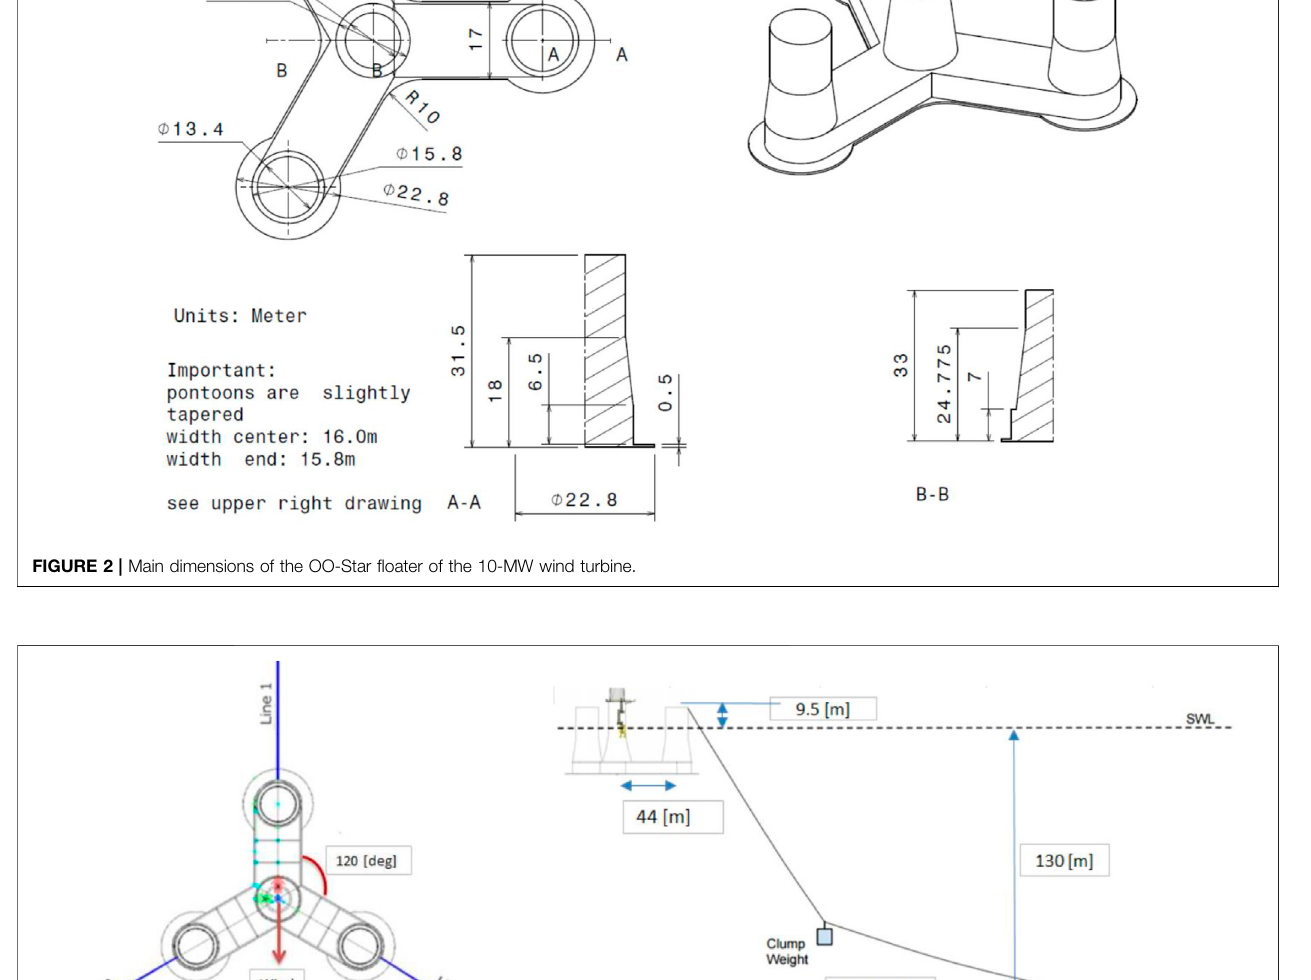
Frontiers in Mechanical Engineering |